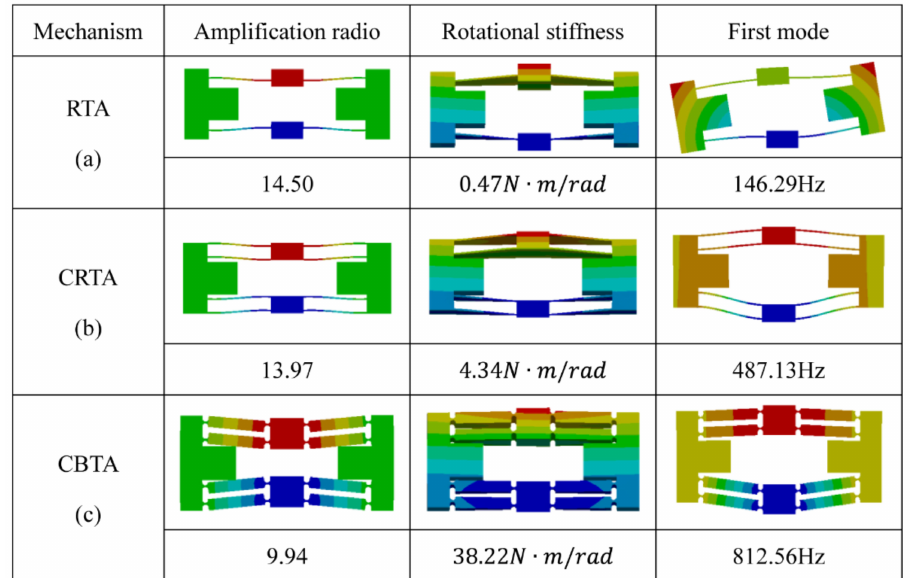
Figure 2. Comparison of three displacement amplifying mechanisms. ( a ) RTA; ( b ) CRTA;( c )